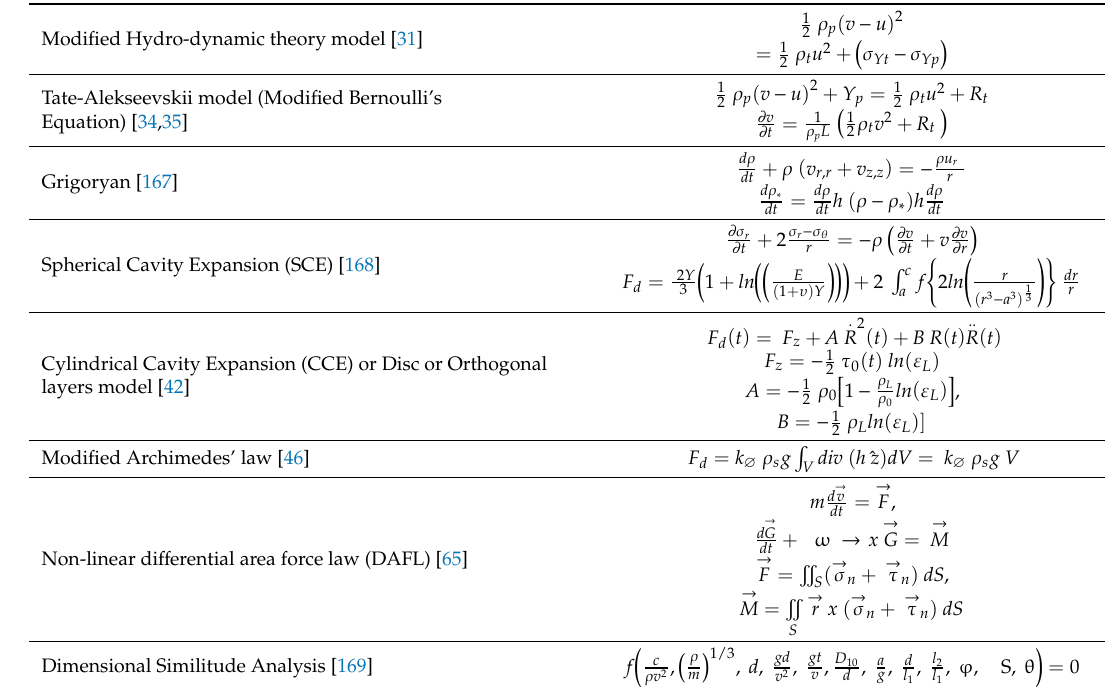
Table A2. Analytical Methods and Basic Equations